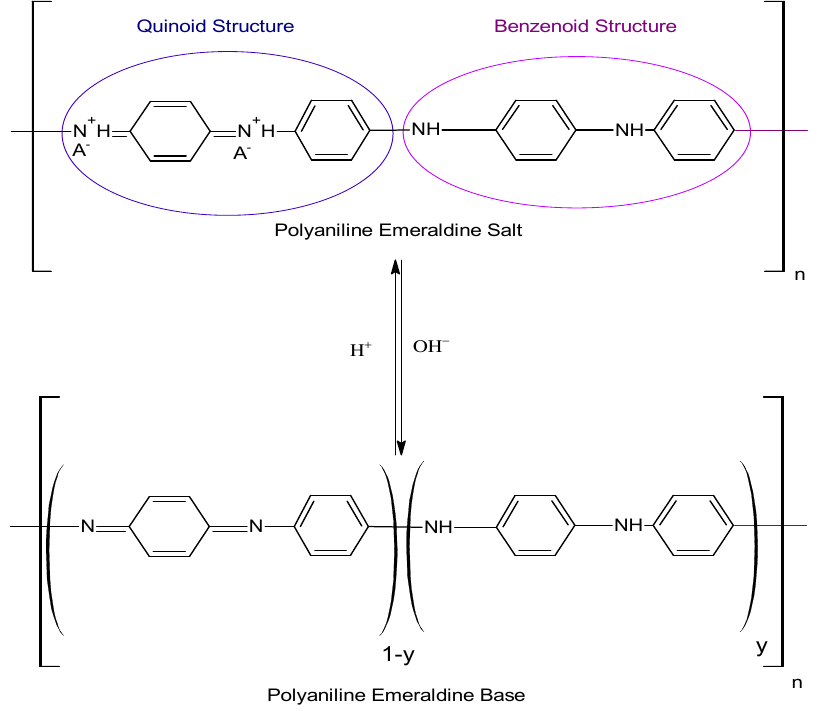
Figure 1. Chemical structures of polyaniline emeraldine salt form (PANI-ES) and polyaniline emeraldine base form (PANI-EB), where A denotes an anion such as Cl − . Adapted from Stejskal, 2020 [22]. FT-IR spectral variations of PANI-ES and PANI-EB could be visualized by the presence of strong vibrations of PANI-EB in comparison to PANI-ES (Figure 2a). The main char- acteristic peaks in PANI-ES recorded at 1450 cm − 1 and 1557 cm − 1 were attributed to the stretching vibrations of benzenoid unit and quinoid unit groups, respectively [20,33]. The broad shoulder located around 3400 cm − 1 could be assigned to N-H stretching [14]. The peaks at 1290 cm − 1 and 788 cm − 1 corresponded to secondary aromatic amine C–N stretch- ing and aromatic C–H out of plane bending, respectively [33]. These peaks were moved to higher wavenumbers, which were located at 1298 cm − 1 and 820 cm − 1 in PANI-EB. The peaks related to benzenoid and quinoid shifted to 1493 and 1587 cm − 1 . Furthermore, 1218 cm − 1 was related to C–N + • stretching vibration in PANI-ES and this peak disappeared in the FT-IR spectrum of PANI-EB [34,35]. The peaks were observed at 1069 cm − 1 and 581 cm − 1 indicating residual sulfate anions due to the usage of the oxidant source of am- monium peroxydisulfate. In PANI-EB, the peaks corresponding to the presence of sulfate anions disappeared while a new peak appeared at 1160 cm − 1 that was ascribed to the aromatic C–H in plane bending vibration